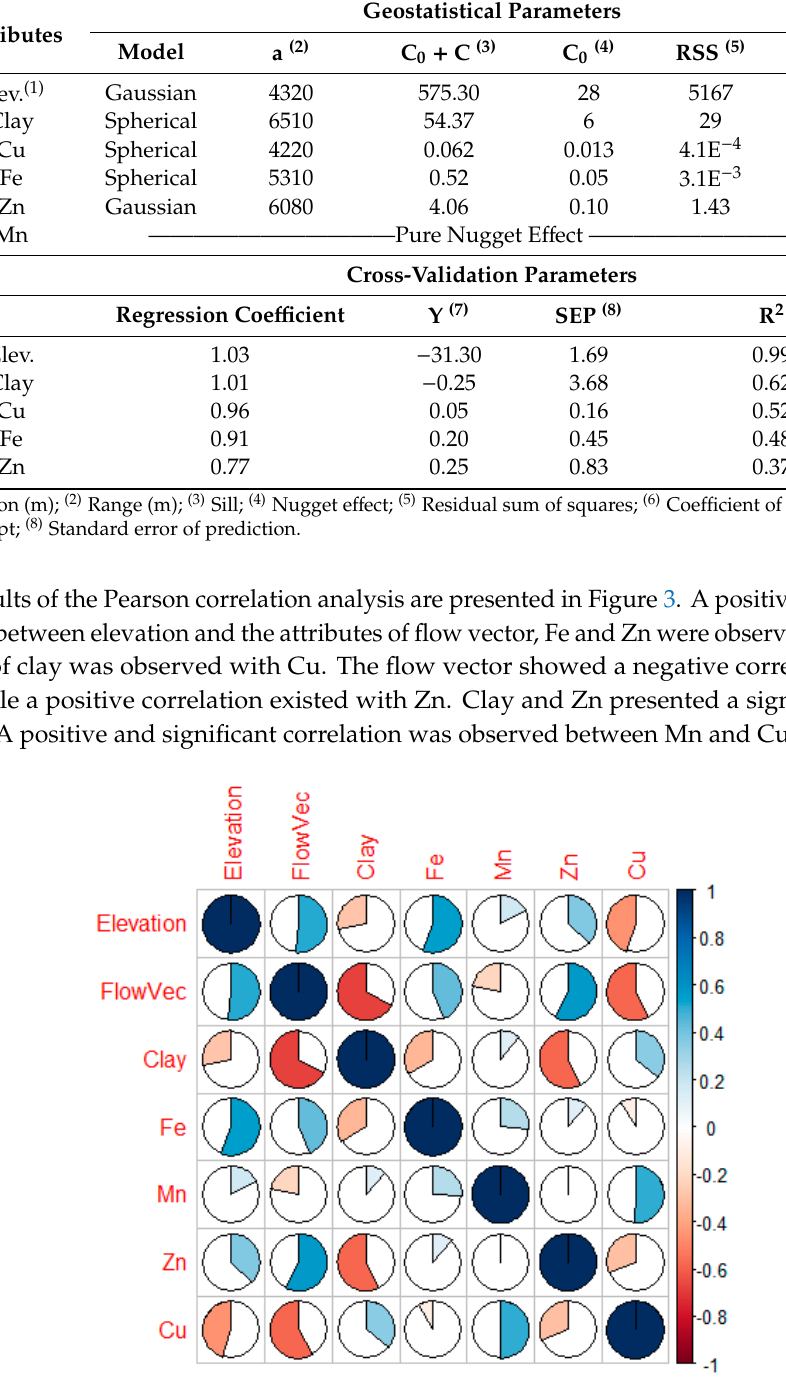
Figure 3. Pearson’s correlation coefficients between the attributes analyzed. FlowVec: Flow Vector